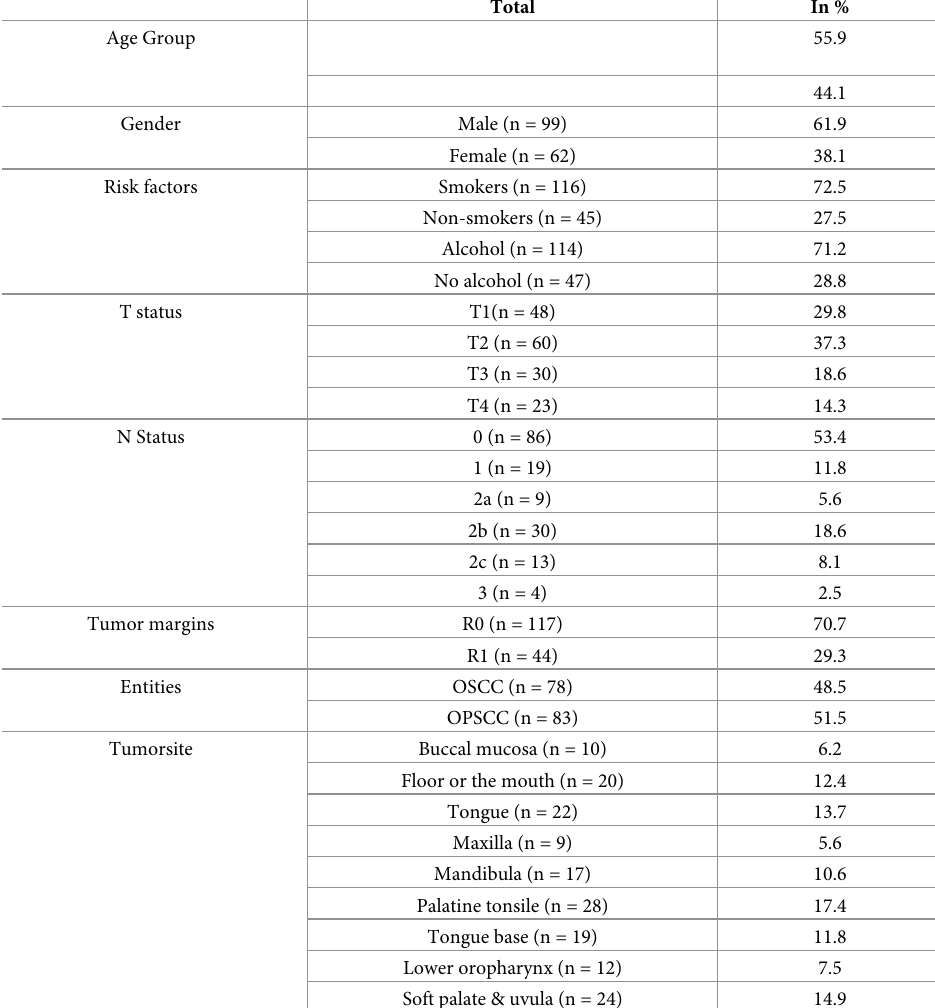
Table 1. Epidemiological features of the patients cohort (n =